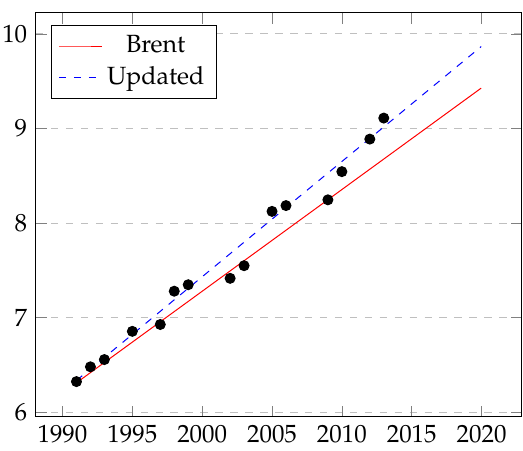
Figure 4. D 1/2 versus year Y for ECM.